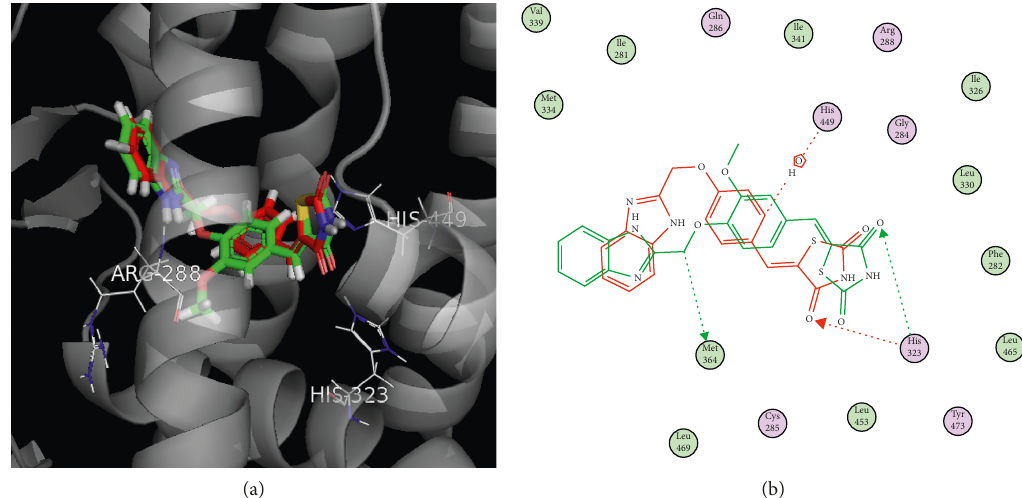
Figure 5: 3-D binding diagram (a) and 2-D overlay (b) of 1 (red) and 2 (green) into the PPAR c ligand site, sharing the same orientation.